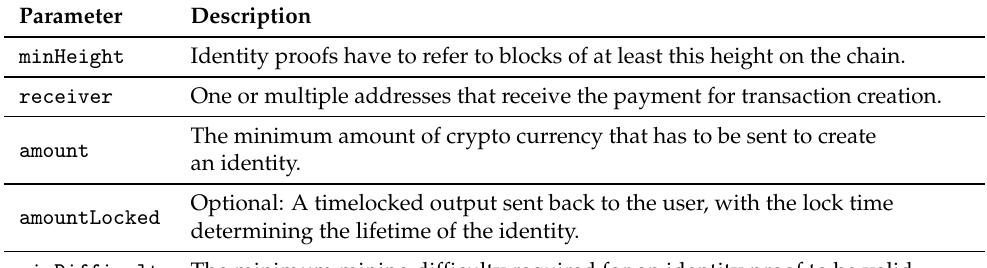
Table 1. Overview of Rechained